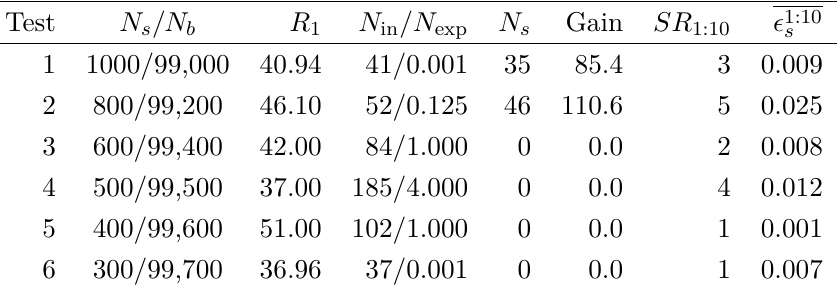
Table 7 . Sample results of RanBoxIter runs on 100,000 event samples from the HEPMASS dataset, with varying signal fraction. See the text for more